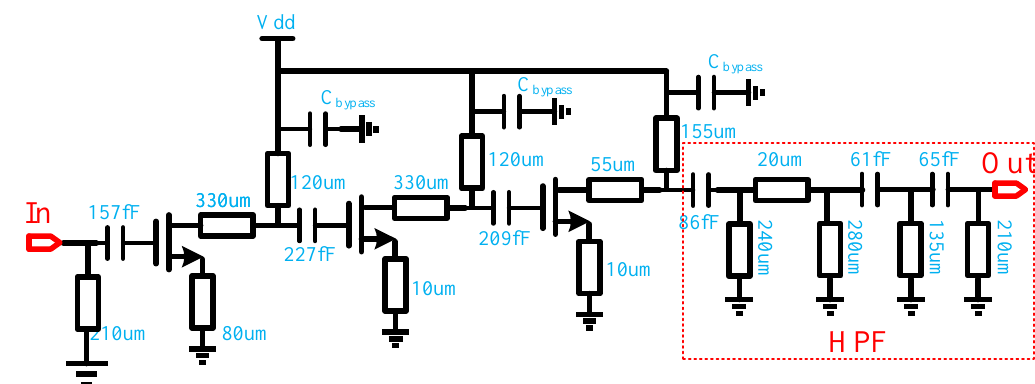
Figure 4. Schematic of the power amplifier with HPF.